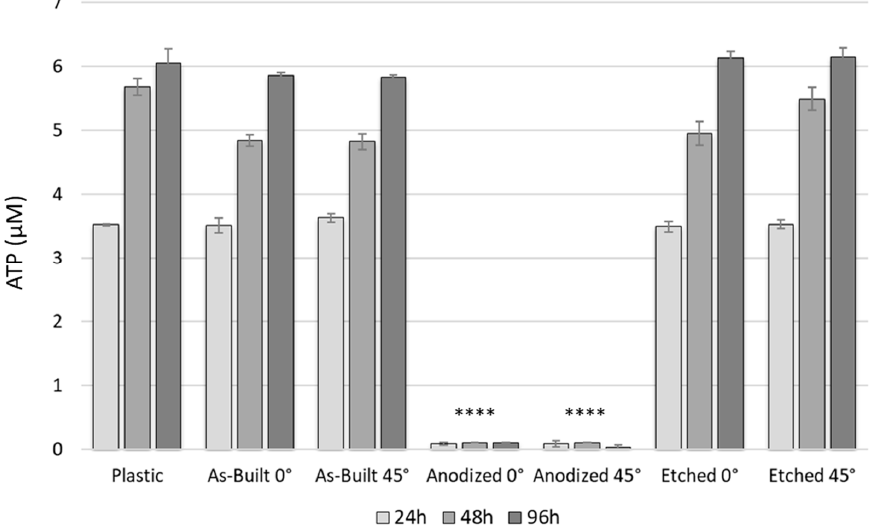
Figure 6. ATP ( μ m) concentrations of MC3T3-E1 cells cultured in conditioned and in control medium at different time points (24 h, 48 h, and 96 h). Unpaired t -test was applied to discriminate differences between MC3T3-E1 cultured on a plastic dish and on each scaffold considering a statistically significant value of p < 0.05 (, **** p < 0.0001).